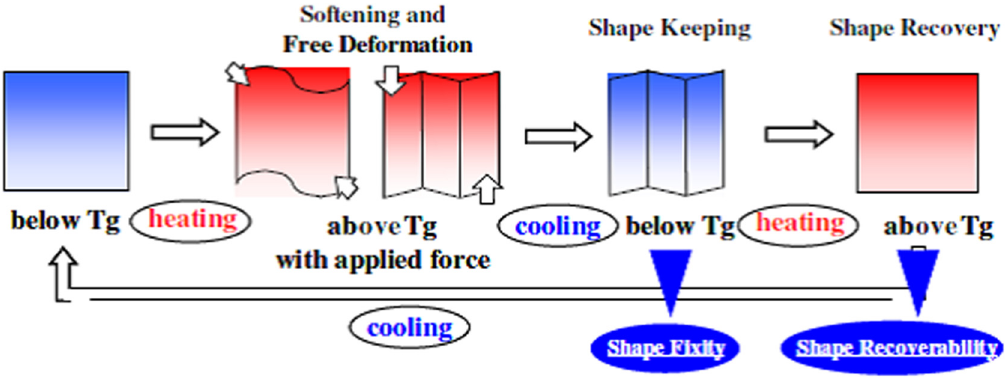
Figure 2: Shape memory steps: ( 1 ) memorized shape after molding and cooling; ( 2 ) free deformation due to rubber elasticity of amorphous portion by heating over T g under an applied force; ( 3 ) shape fi xity by cooling below T g ; and ( 4 ) shape recovery by heating over T g ( 40 ) . Reproduced with permission from Elsevier.